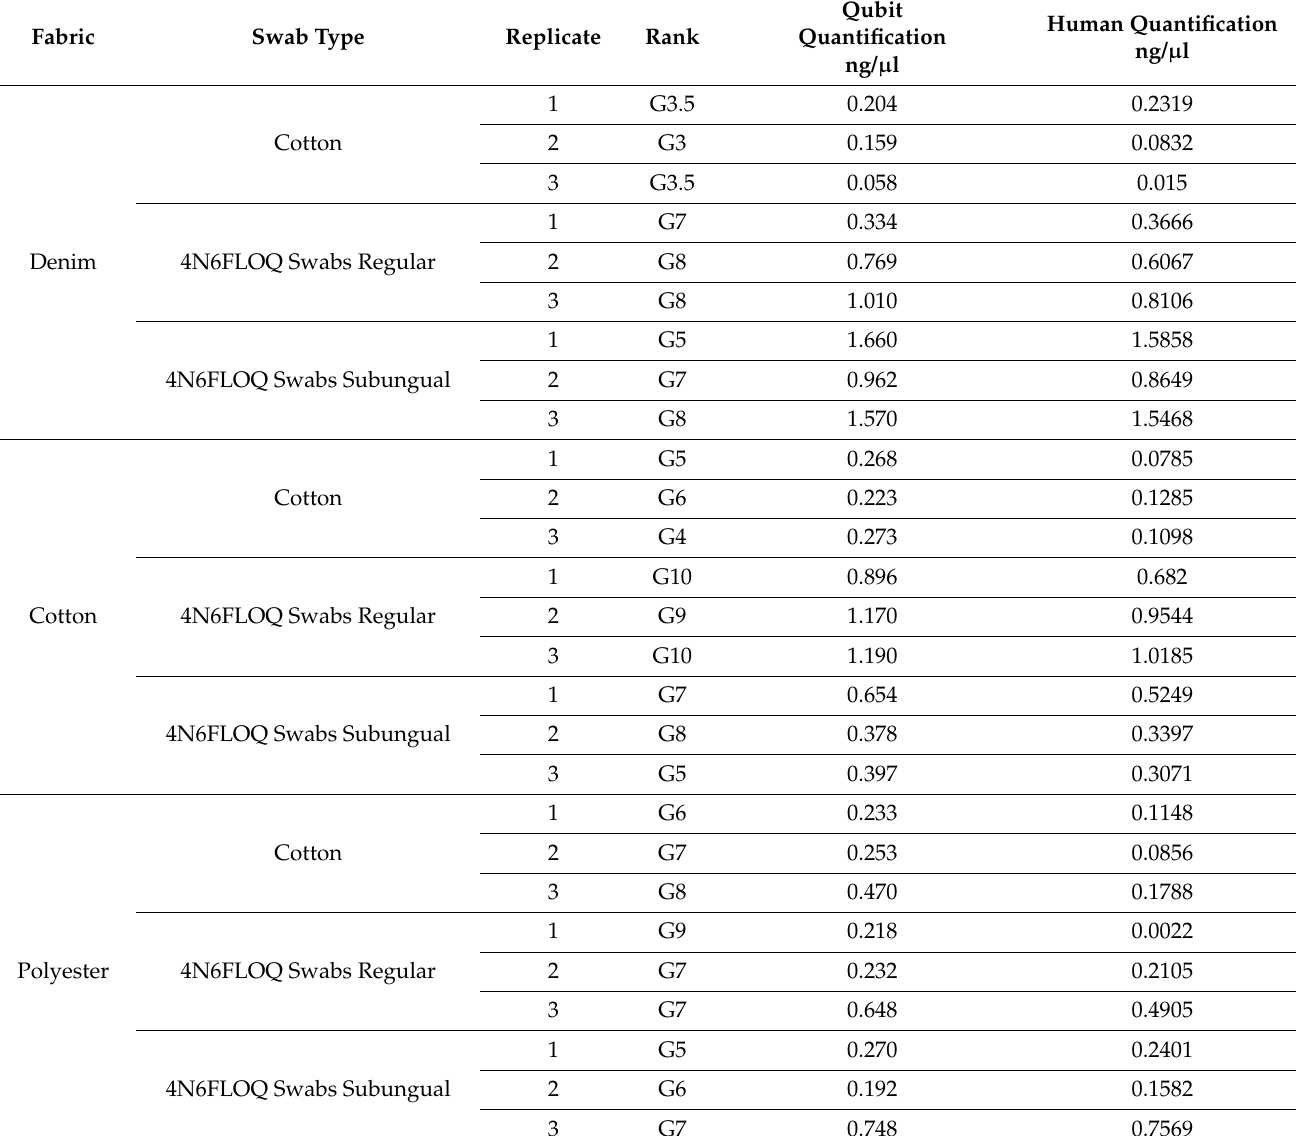
Table 1. Study results summary. Rank—the values of band intensity of immunochromatographic test based on a previous scale; ng/ µ L, DNA concentrations per fabric, and swab type. Replicates are from the same samples in three different